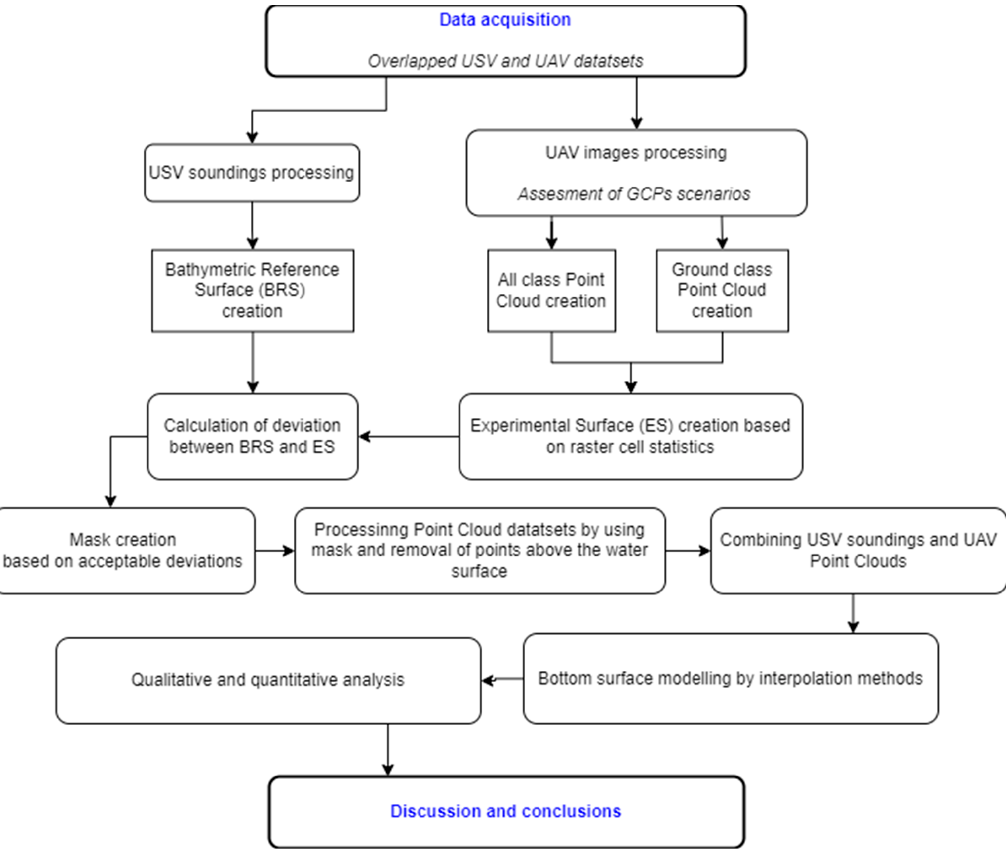
Figure 4. The research process adopted in this study.